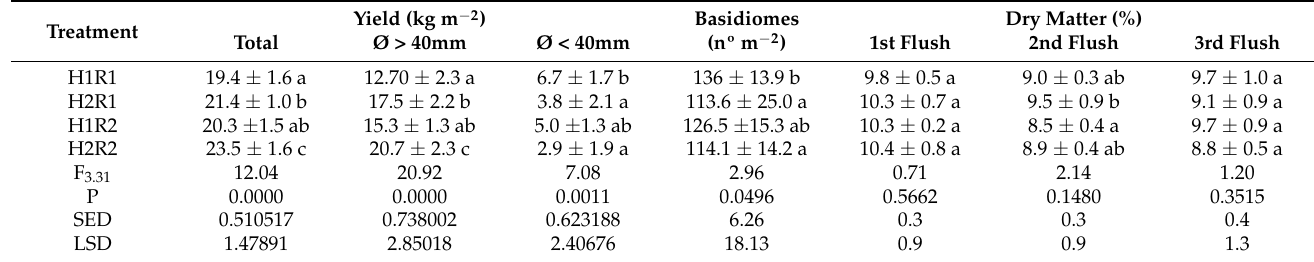
Figure 1. Volumetric water content in the casing for the treatments established in the trials. H1R1, low initial water content with a light irrigation program; H2R1, high initial water content with a light irrigation program; H1R2, low initial water content with a moderate irrigation program; H2R2, high initial water content with a moderate irrigation program. ( a ) trial A; ( b ) trial L-1; ( c ) trial L-2; ( d ) trial C-1; ( e ) trial C-2. Table 2. Main quantitative and qualitative production parameters assessed in Trial A (yield, number of basidiomes and dry matter